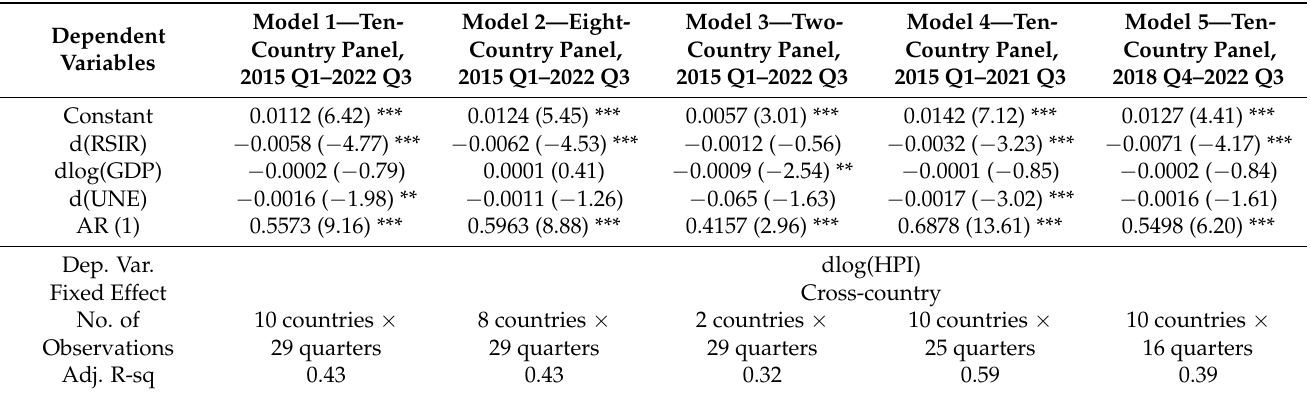
Figure 7. Scatterplots of house prices year-on-year changes (HPIyoy) and real short-term interest rates (RSIRs), for 2015 Q1–2022 Q3, in ten countries. Source: data from OECD (2022a) [36]. Legend: Australia (AUS), Canada (CAN), Germany (DEU), France (FRA), Great Britain (GBR), Italy (ITA), Japan (JAP), South Korea (KOR), New Zealand (NZL), and the United States of America (USA). Table 3. Results of the ten-country panel regression models on house price change and real short-term interest rates, with cross-country fixed effect and AR